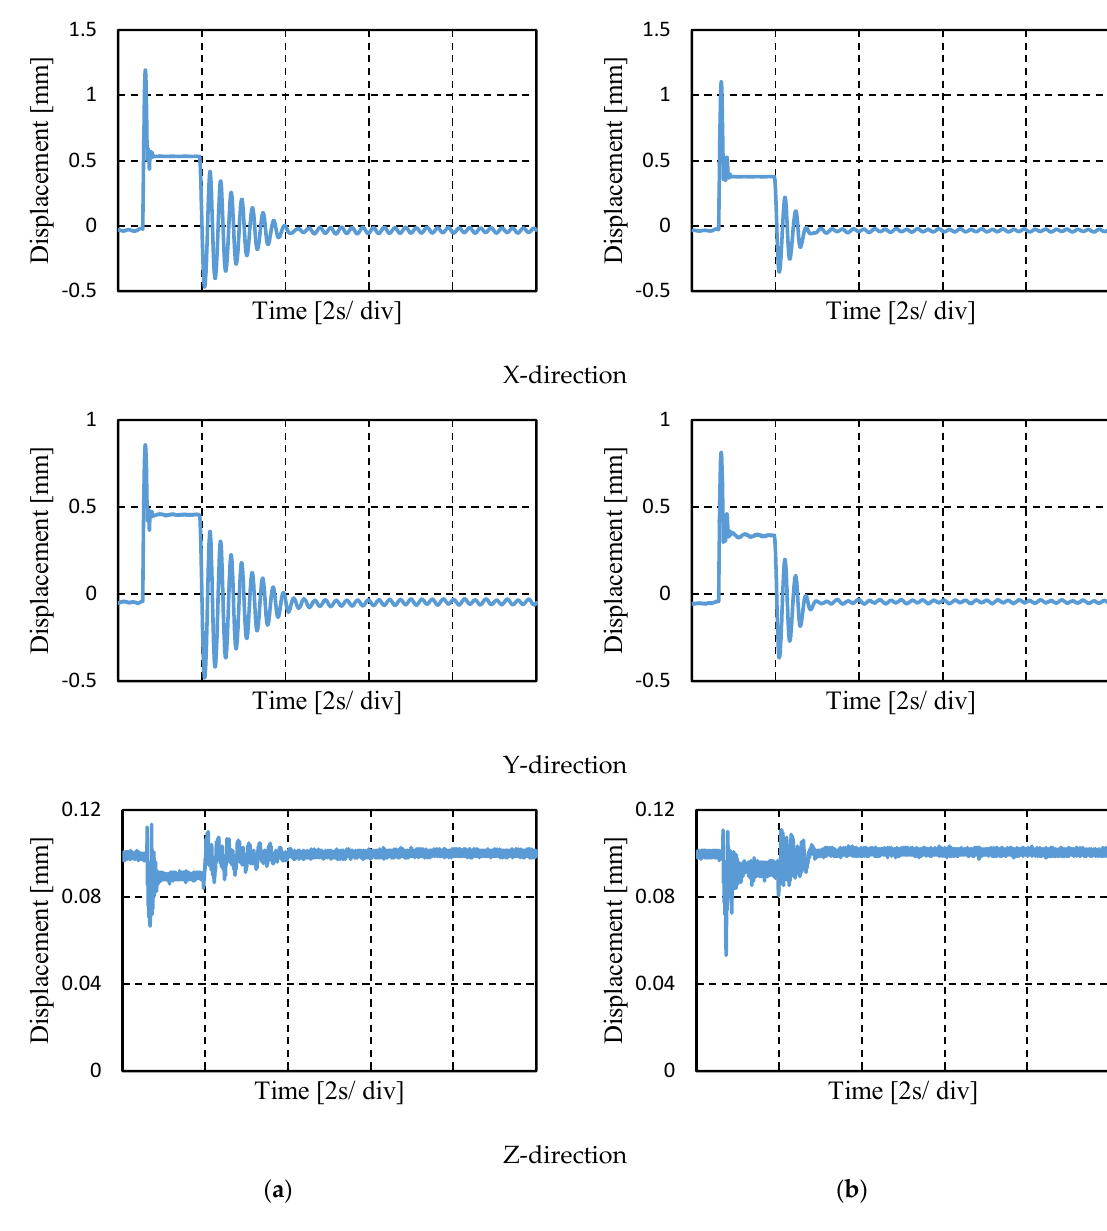
Figure 10. Lateral vibration reduction by applying modified stiffness control with same value of q = 10, ( a ) control current, ∆ I = 0.1 A and ( b ) control current, ∆ I = 0.2 A.